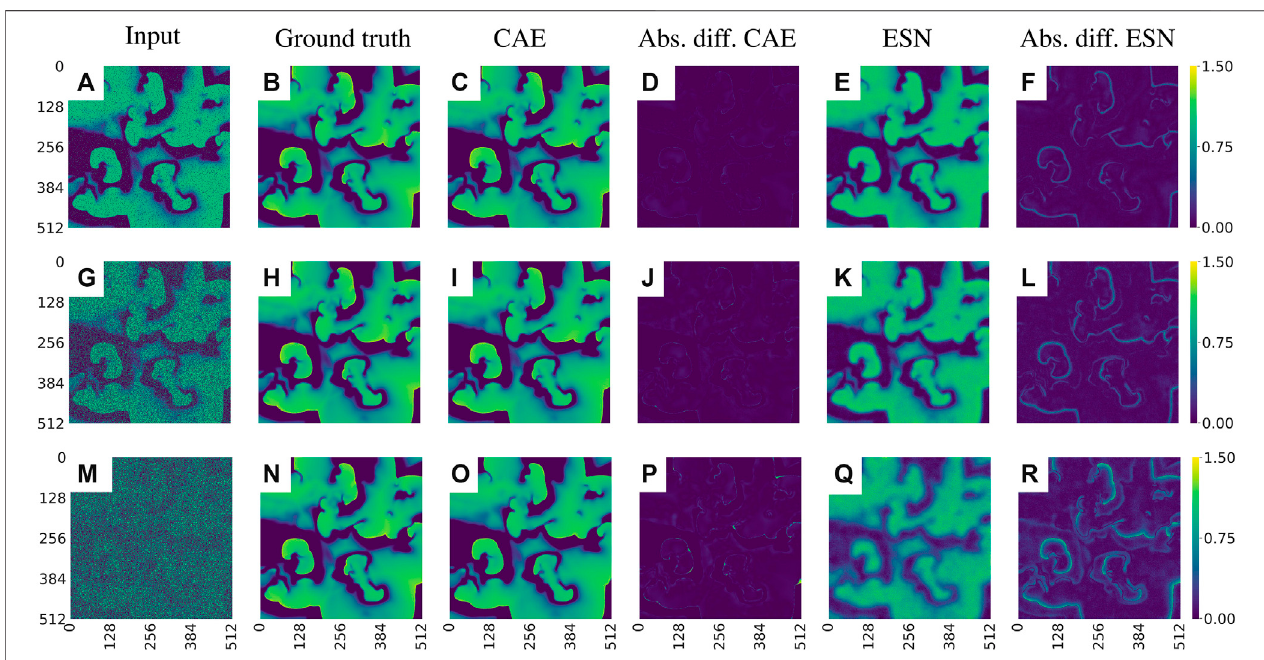
FIGURE8 | Exemplary visualization ofthe input and outputfor both networks for data withdifferent noiselevels p : (A) – (F) p (cid:2) 0.1, (G) – (L) p (cid:2) 0.5, and (M) – (R) p (cid:2) 0.9. Comparing the absolute differences between the prediction and the ground truth [ (D), (J), (P) for the CAE and (F), (L), (R) for the ESN] one can see that the CAE is less sensitive to noise. Note that the errors develop primarily on the fronts of the waves.